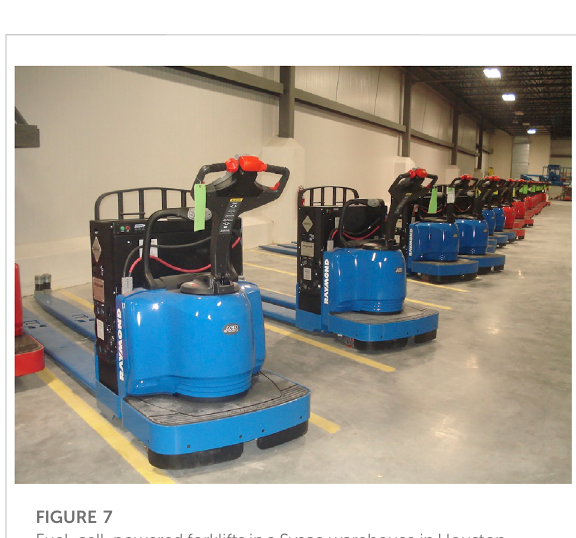
FIGURE 7 Fuel-cell-poweredforklifts inaSysco warehouseinHouston, where they operated in part in a refrigerated